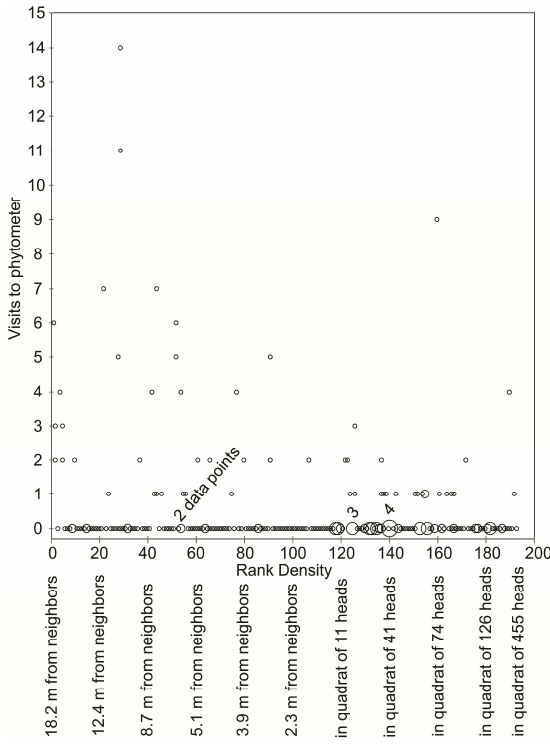
F IGURE 3. Phytometer visits in 2009 scattered against rank density. Bubble size indicates the number of overlapping data points. Density had a negative effect on visitation.